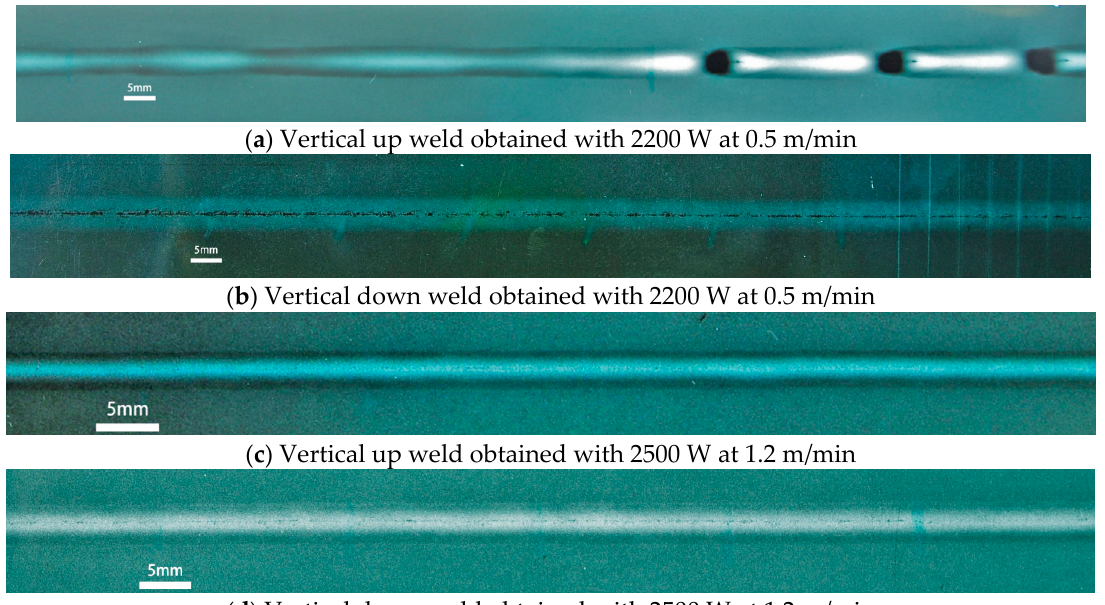
Figure 5. X-ray scanning results for the four laser butt welds.